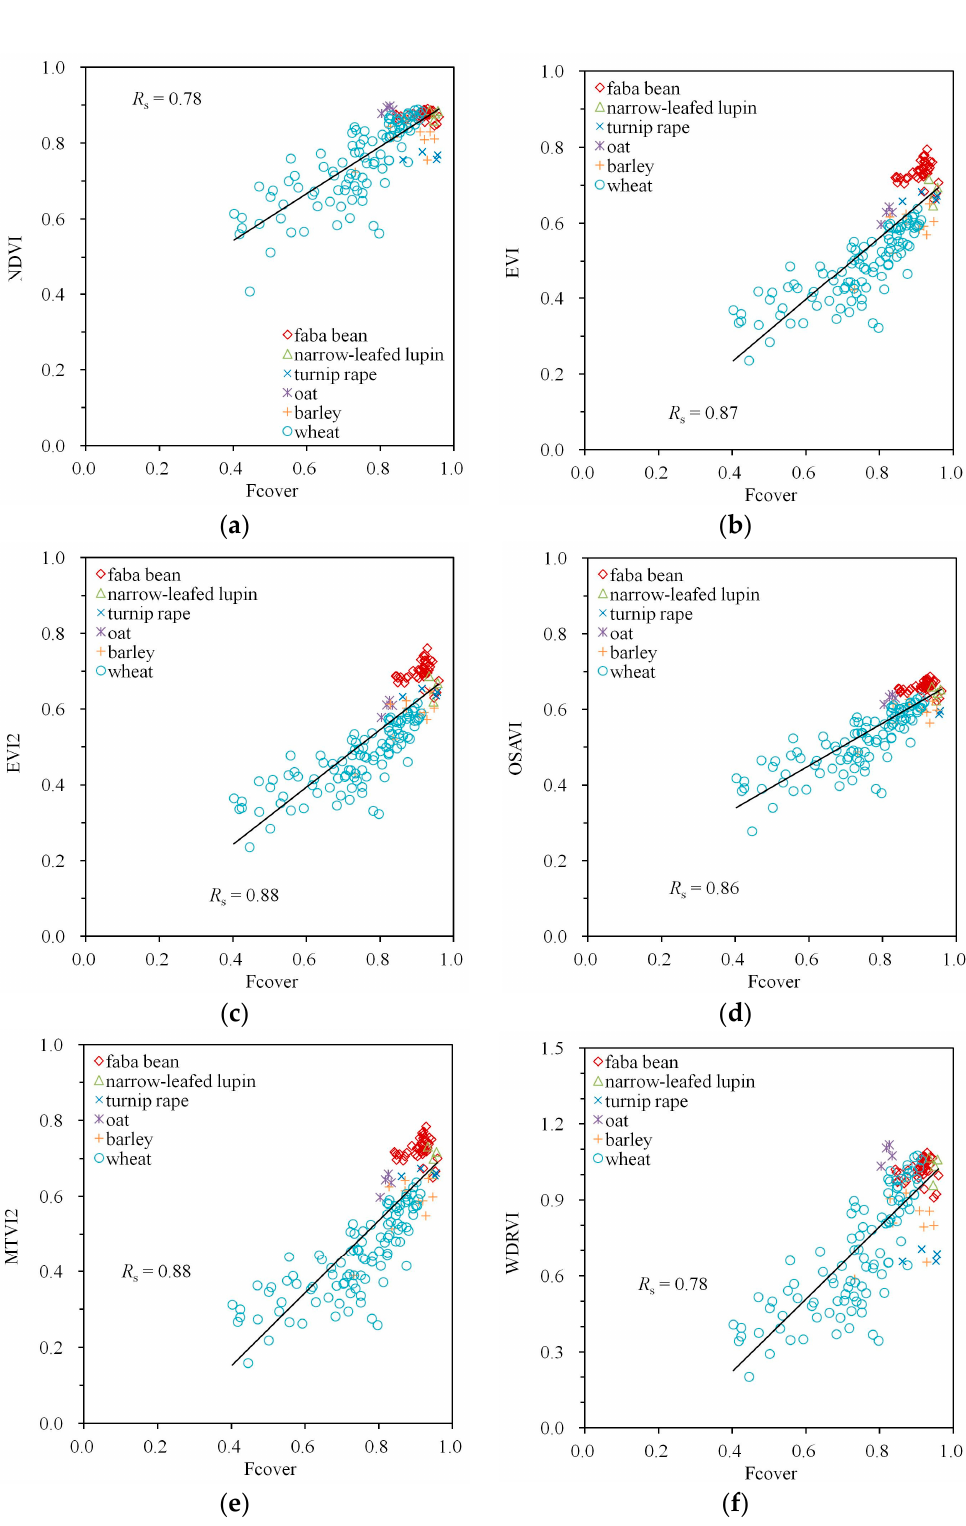
Figure 5. Empirical relationships between Fcover and VIs calculated from Spearman’s correlation coefficient R s : ( a ) NDVI, ( b ) EVI, ( c ) EVI2, ( d ) OSAVI, ( e ) MTVI2, ( f ) WDRVI. A simple trend line calculated from linear regression was added to visualize the trend of the variation.